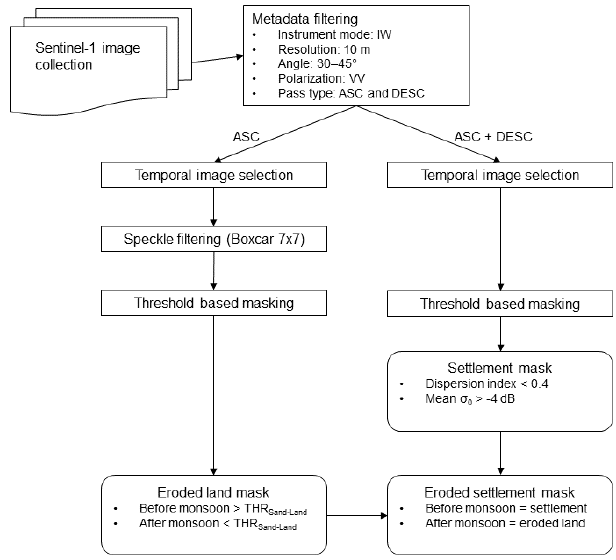
Figure 2. Flowchart of the final implementation to detect eroded farmland and settlement. THR: